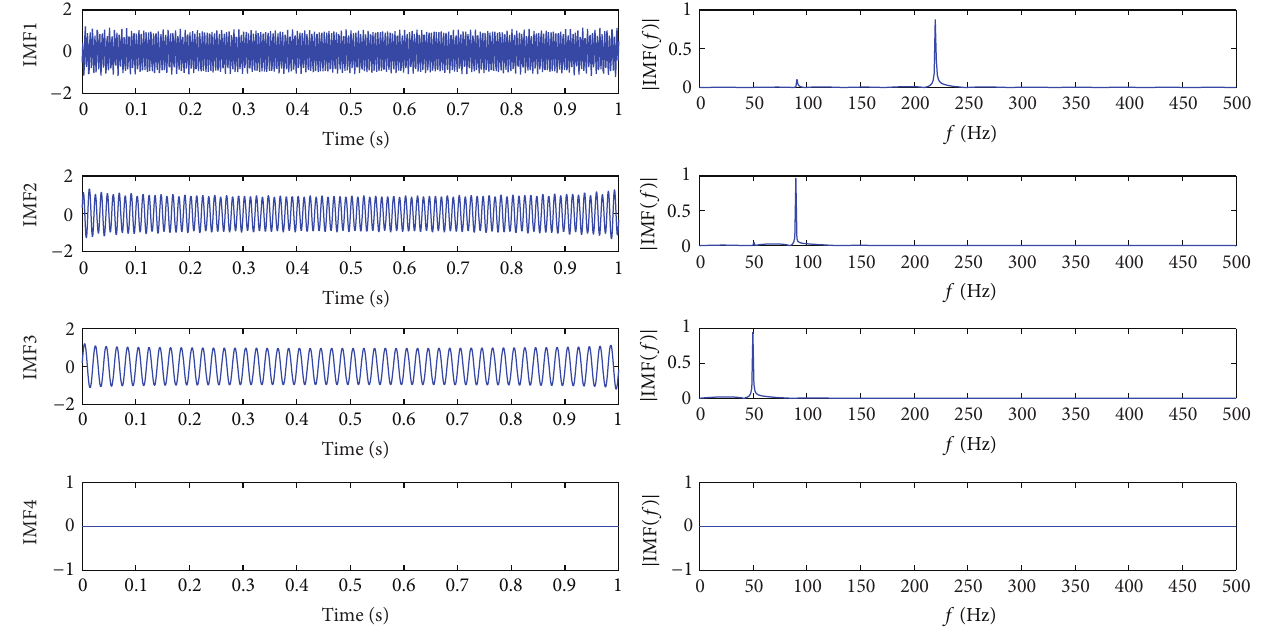
Figure 4: Main IMF and Hilbert spectrum of IMFs obtained by OEMD.